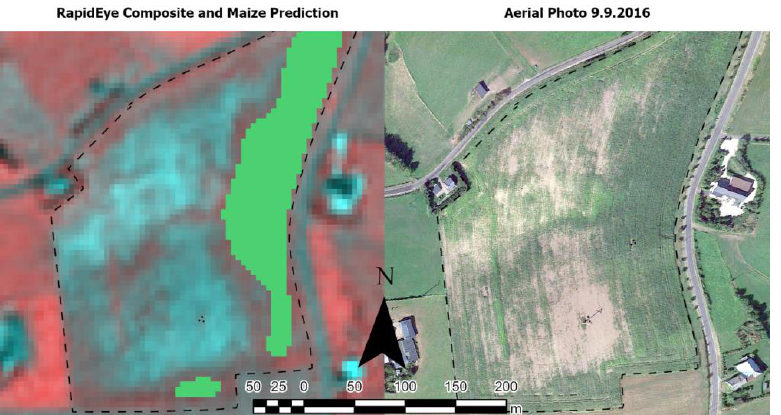
Figure 3. Visual clarification of different approaches of maize classification. Data included in the official statistics include the whole area of the maize field as shown by the dashed lines including large spots of bare soil as visible in the aerial photo. In contrast, the remote sensing-based classification approach only classifies pixel as ‘maize’ that are in fact maize-covered as shown by the prediction in green colour in the RapidEye composite.